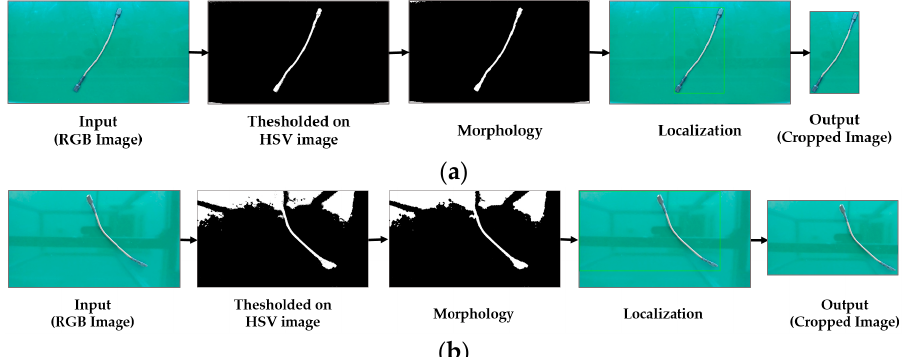
Figure 8. ROI extraction examples. ( a ) Low light level result; ( b ) High light level result.